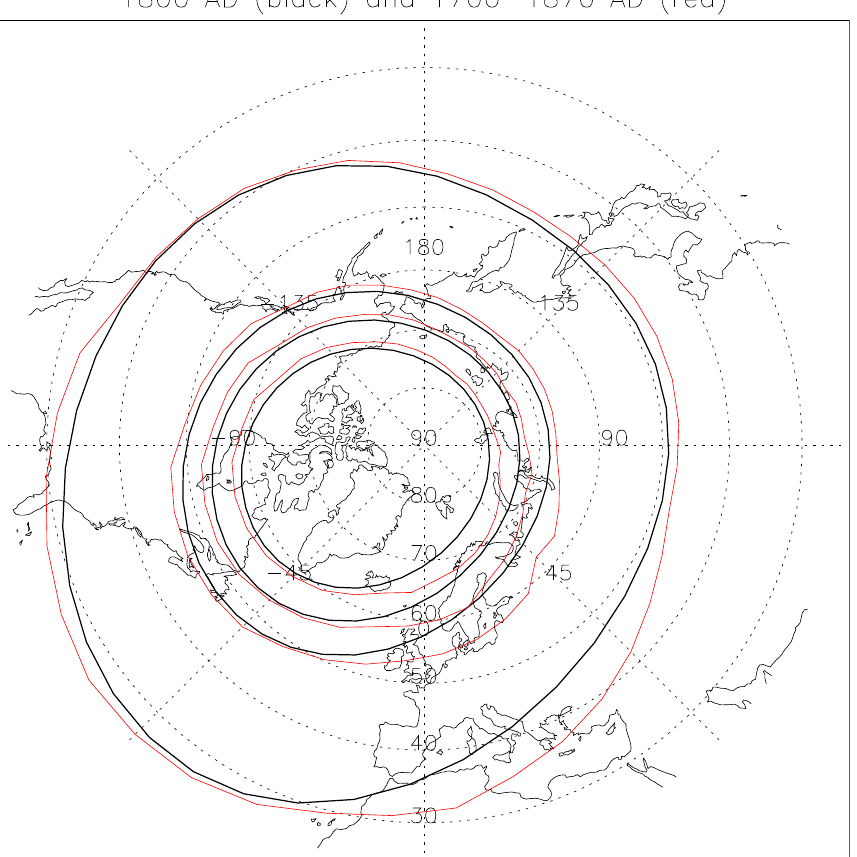
Fig. 7. Reconstructed auroral zone in 1800 AD (black) and possible deformation by a 170-year integration for the time interval between 1700 AD and 1870 AD (red).